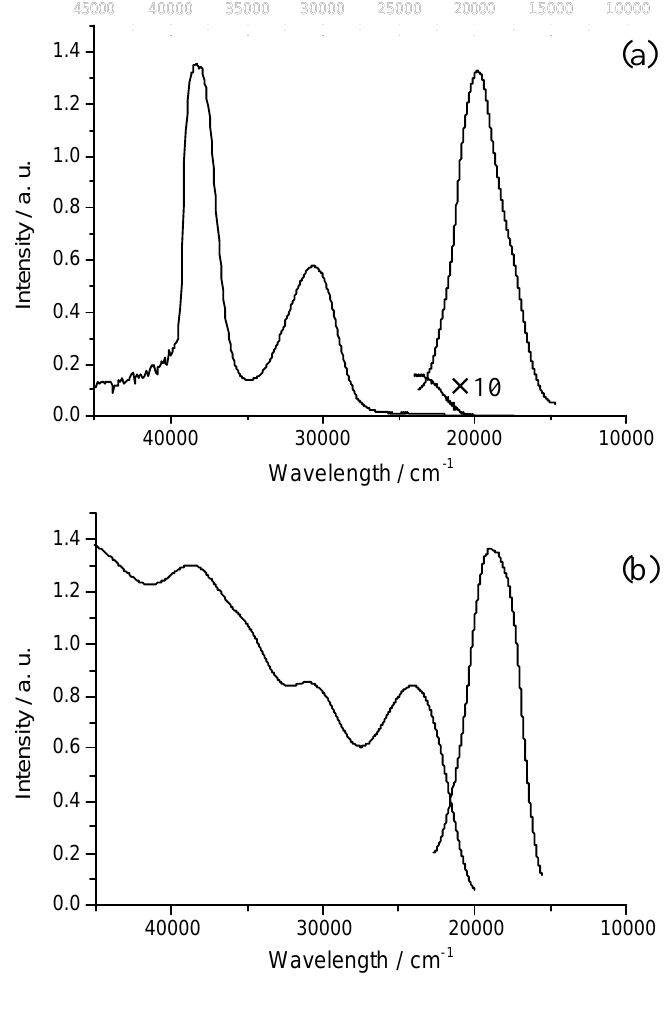
Figure 8: Molecular structure diagram (hydrogens omitted) of 3 . Thermal ellipsoids are drawn at 30% probability